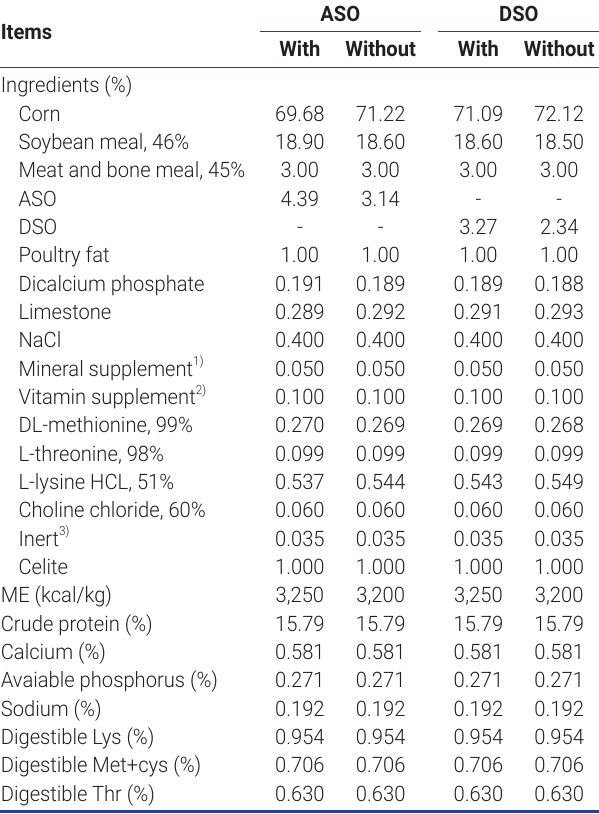
Table 3. Ingredients and chemical composition of experimental diets containing different lipid sources with or without inclusion of emulsi- fier for the finisher (42 to 49 days) phase of broilers